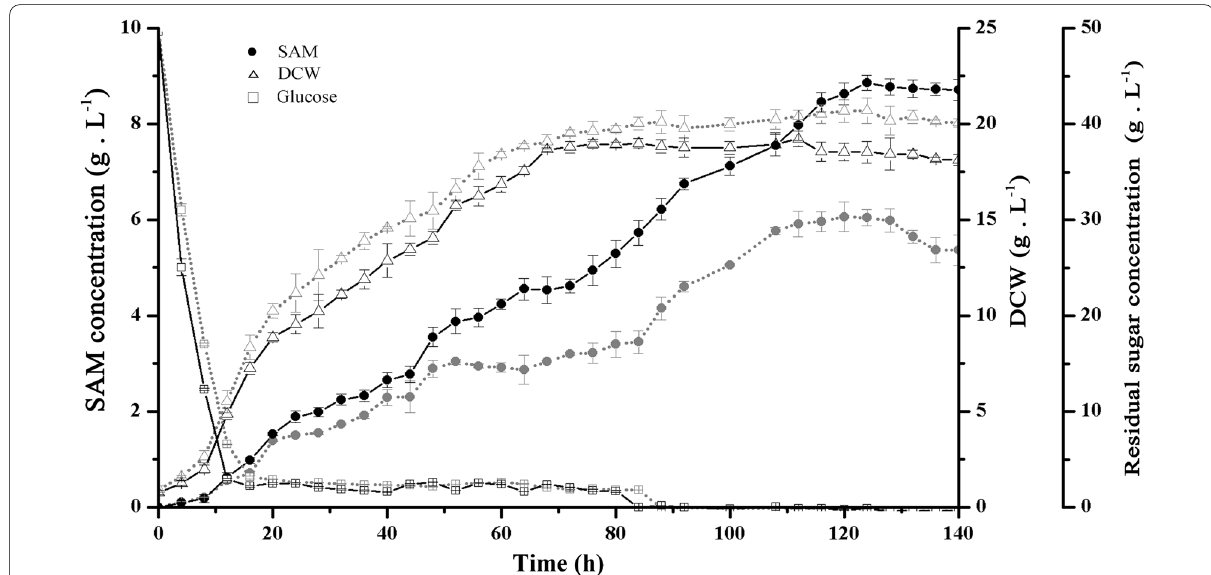
Fig. 7 SAM accumulation capacity of Y kcs1 Δ mls1 ΔGAPmK by fed-batch fermentation. The black solid line represents Y mls1 Δ kcs1 ΔGAPmK strain; The gray dotted line represents Y mls1 ΔGAPmK strain. Error bars correspond to standard error of mean (SEM) of the biological replicates (n